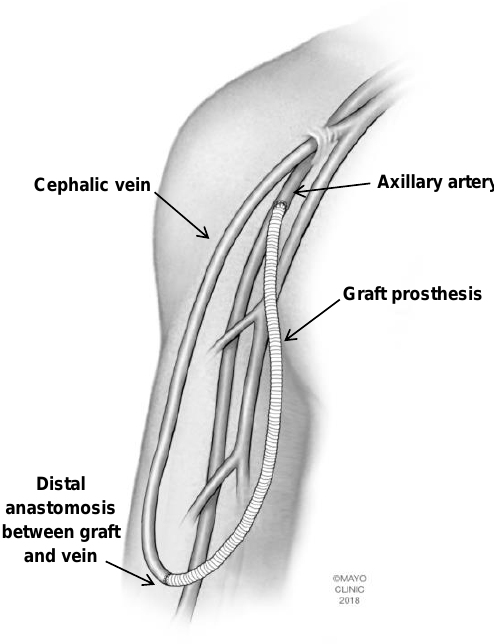
Figure 2. Proximalization of arterial inflow (PAI). The existing arteriovenous fistula is dissected and venous outflow is ligated (not shown). A small diameter graft prosthesis is used to deliver proximalized arterial inflow to the new access site. The proximal end of the graft is anastomosed in a side-to-end fashion to the artery and the distal end is anastomosed in an end-to-end fashion to the vein. Copyright 2018 Mayo Foundation for Medical Education and Research.